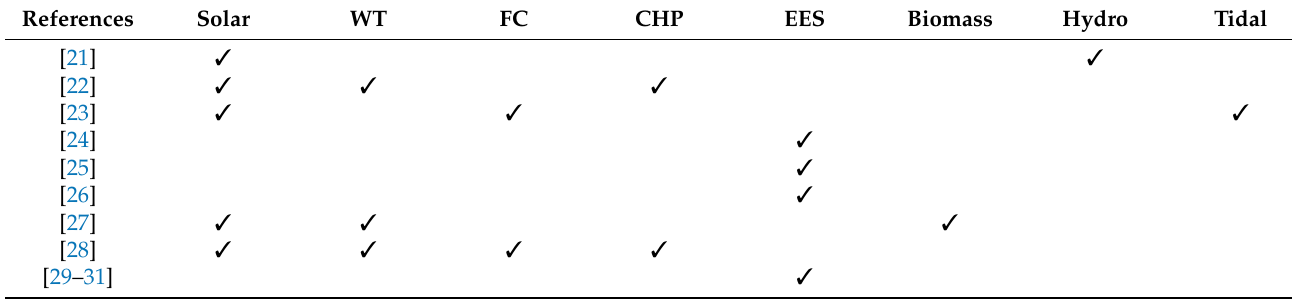
Table 1. Sustainable energy (SE) system in microgrids.